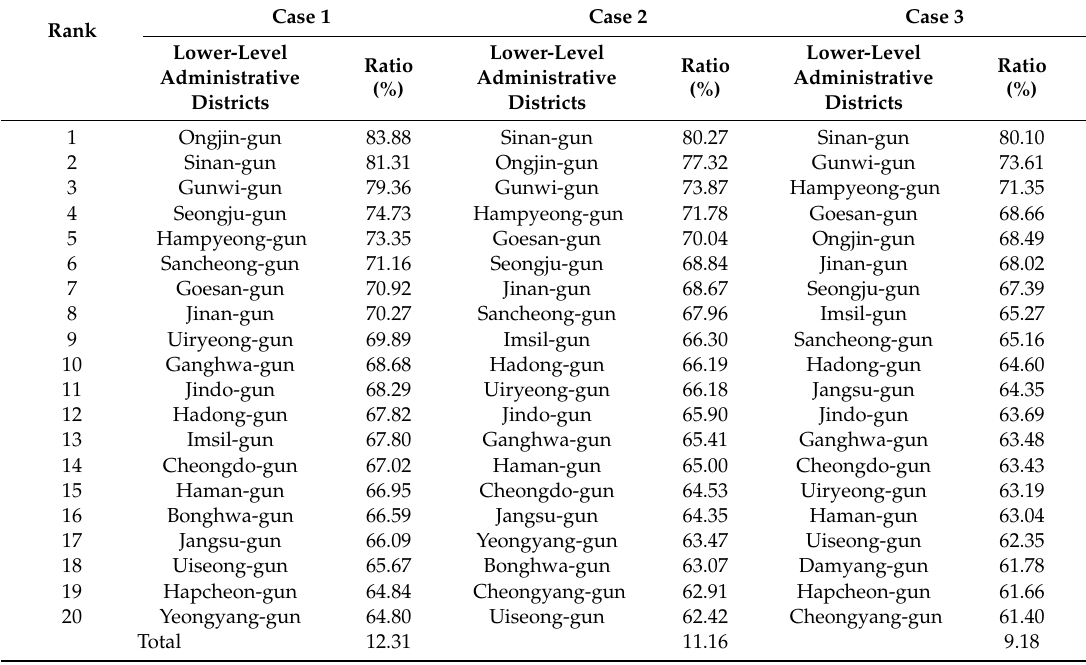
Table 5. Top 20 lower-level administrative districts with the lowest food access and their proportion of the people with LFA by